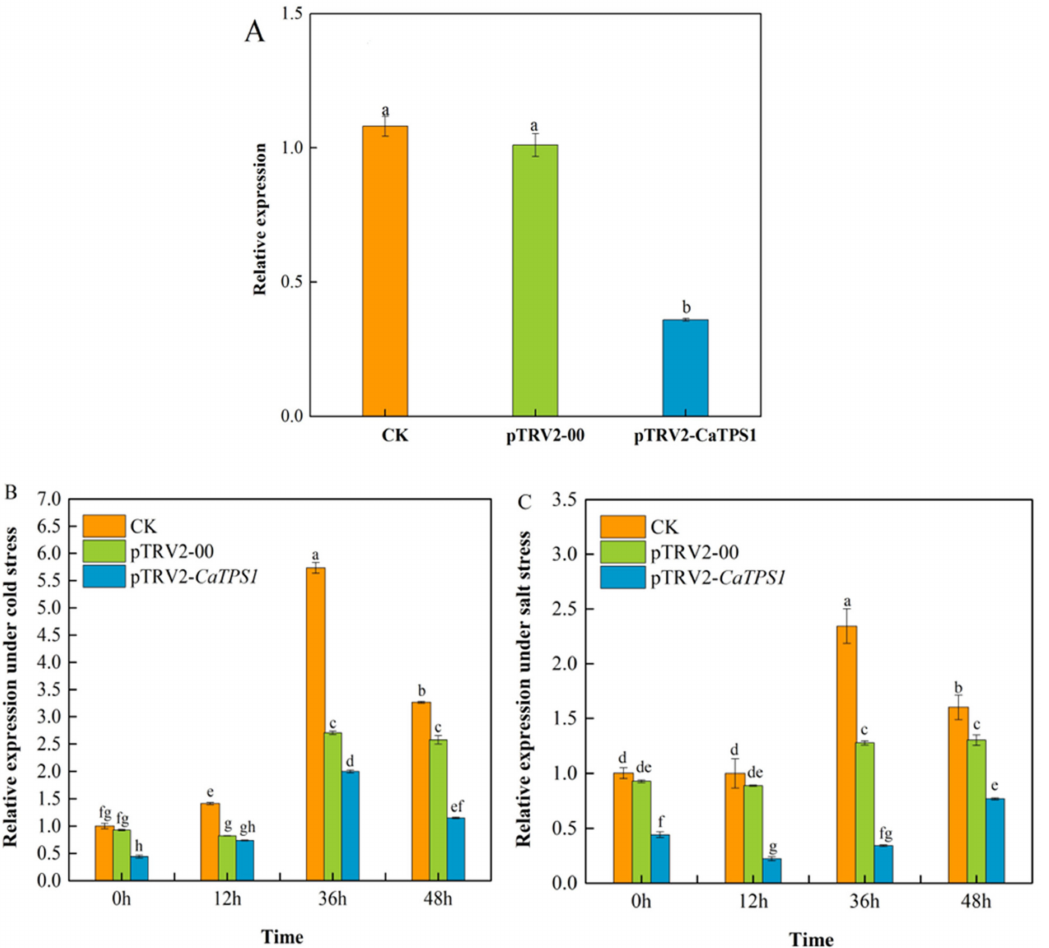
Figure 4. Relative expression of CaTPS1 . ( A ) Relative expression of CaTPS1 in leaves from CaTPS1 - silenced and control pepper plants. Relative expression of CaTPS1 in leaves from CaTPS1